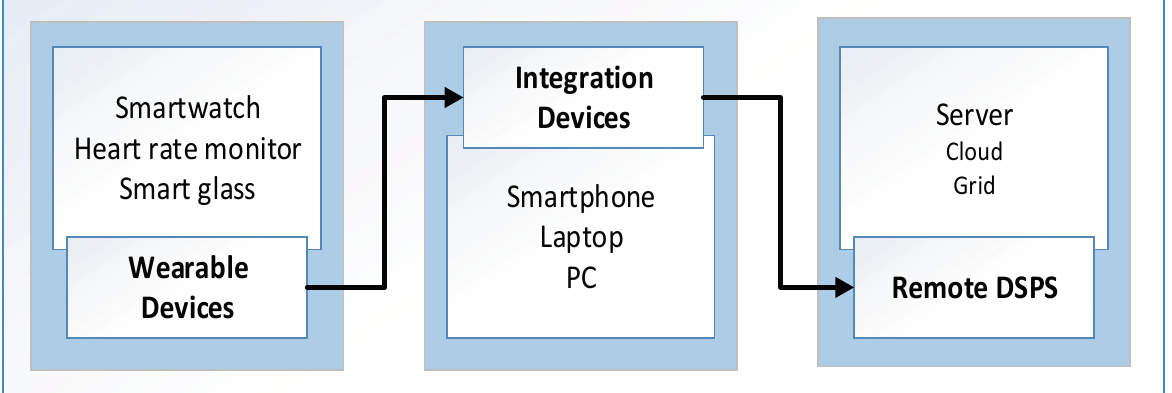
Figure 3. Data flow from PSDs to remote DSPS.